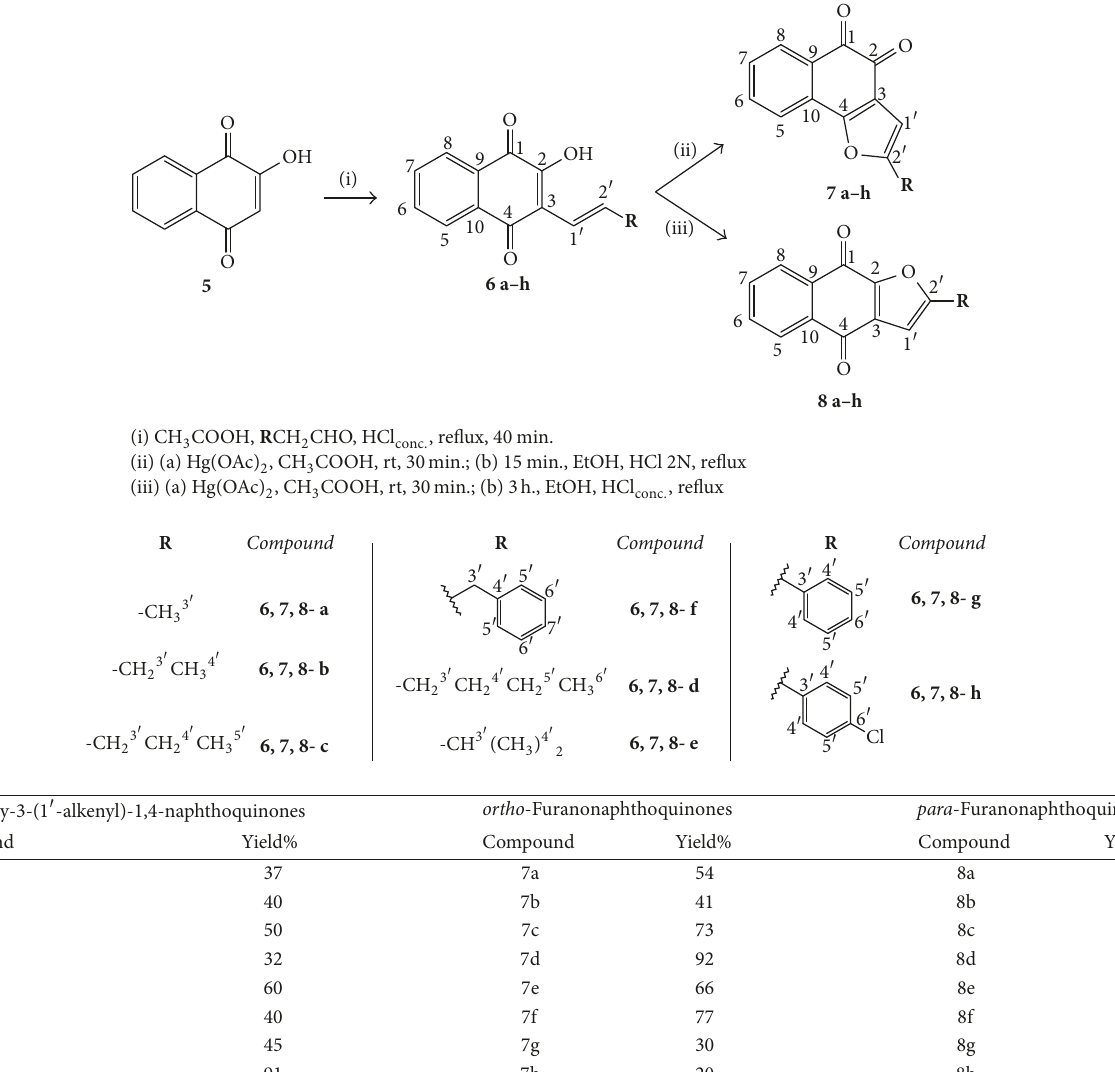
Scheme 1: Synthesis of naphthoquinones 6a–h , 7a–h , and 8a–h and their